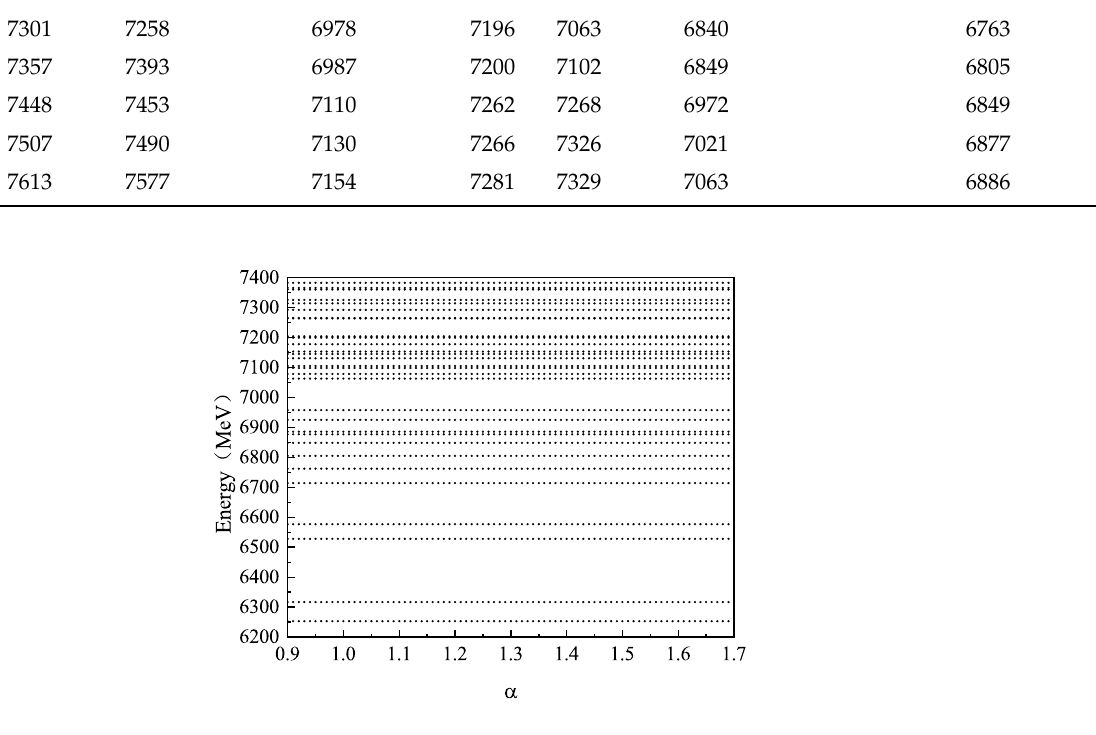
Figure 4. The stabilization plots for the energies of the states for J PC = 0 ++ in the full hidden-color channels coupling ( ( η 8 c η 8 c ) 0 + ( J / ψ 8 J / ψ 8 ) 0 + ( DA ) 0